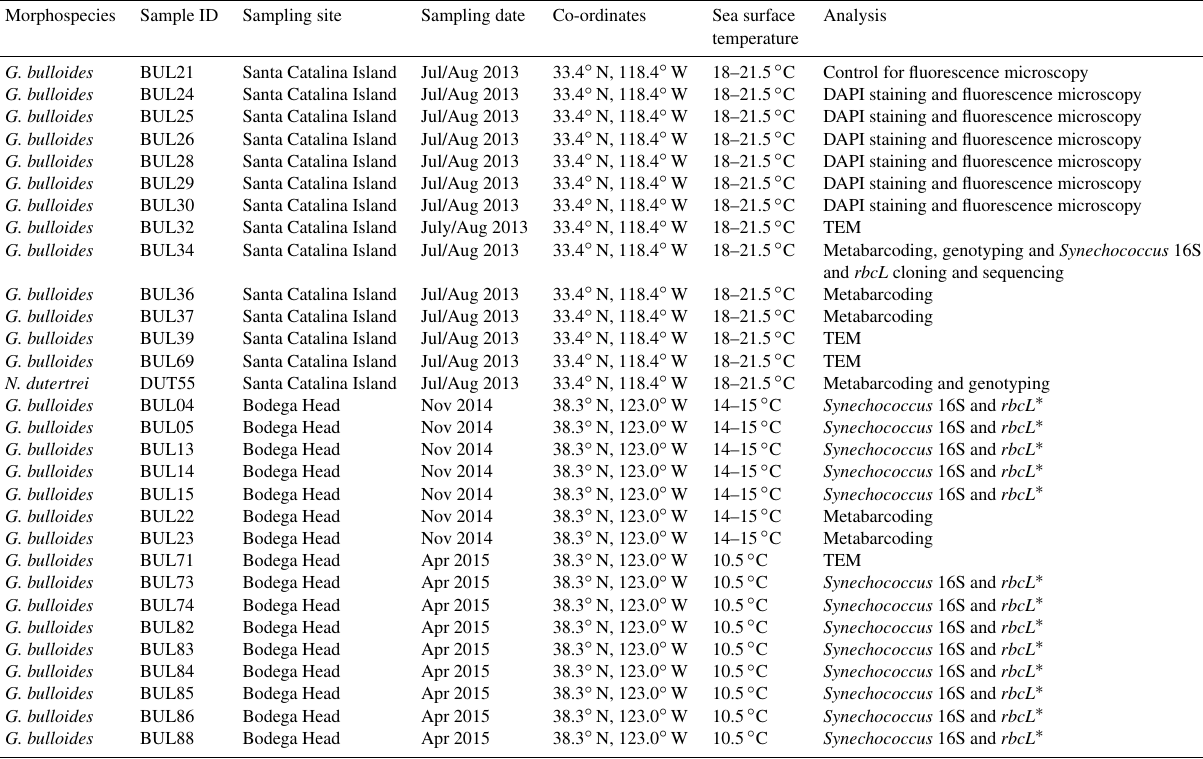
Table 1. Sampling information and details of analyses performed for each planktonic foraminifer specimen collected. Morphospecies Sample ID Sampling